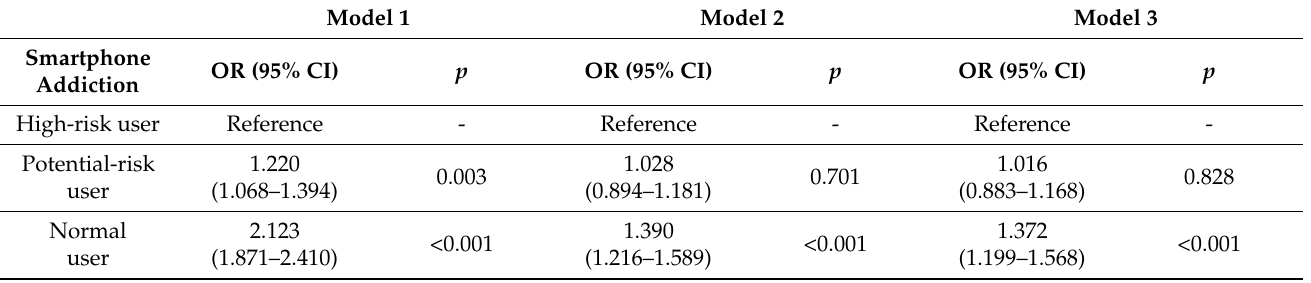
Table 4. Logistic regression analysis of sleep satisfaction based on smartphone addiction.